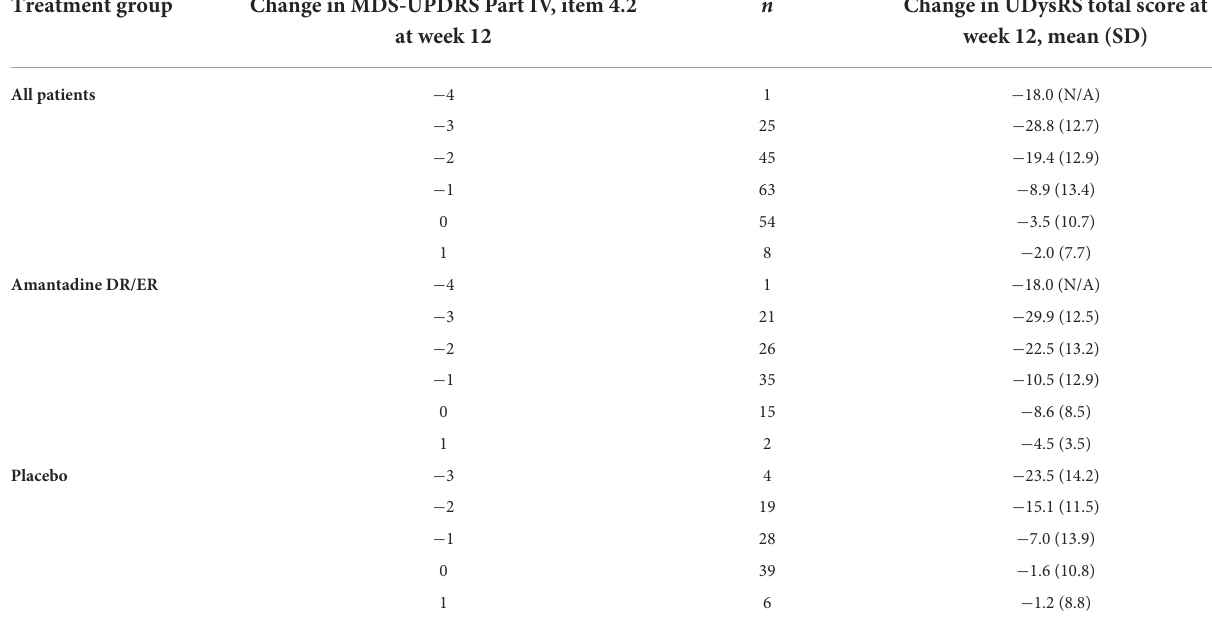
TABLE 2 Mean changes in the UDysRS total score for each level of change in the MDS-UPDRS Part IV, item 4.2. Treatment group Change in MDS-UPDRS Part IV, item